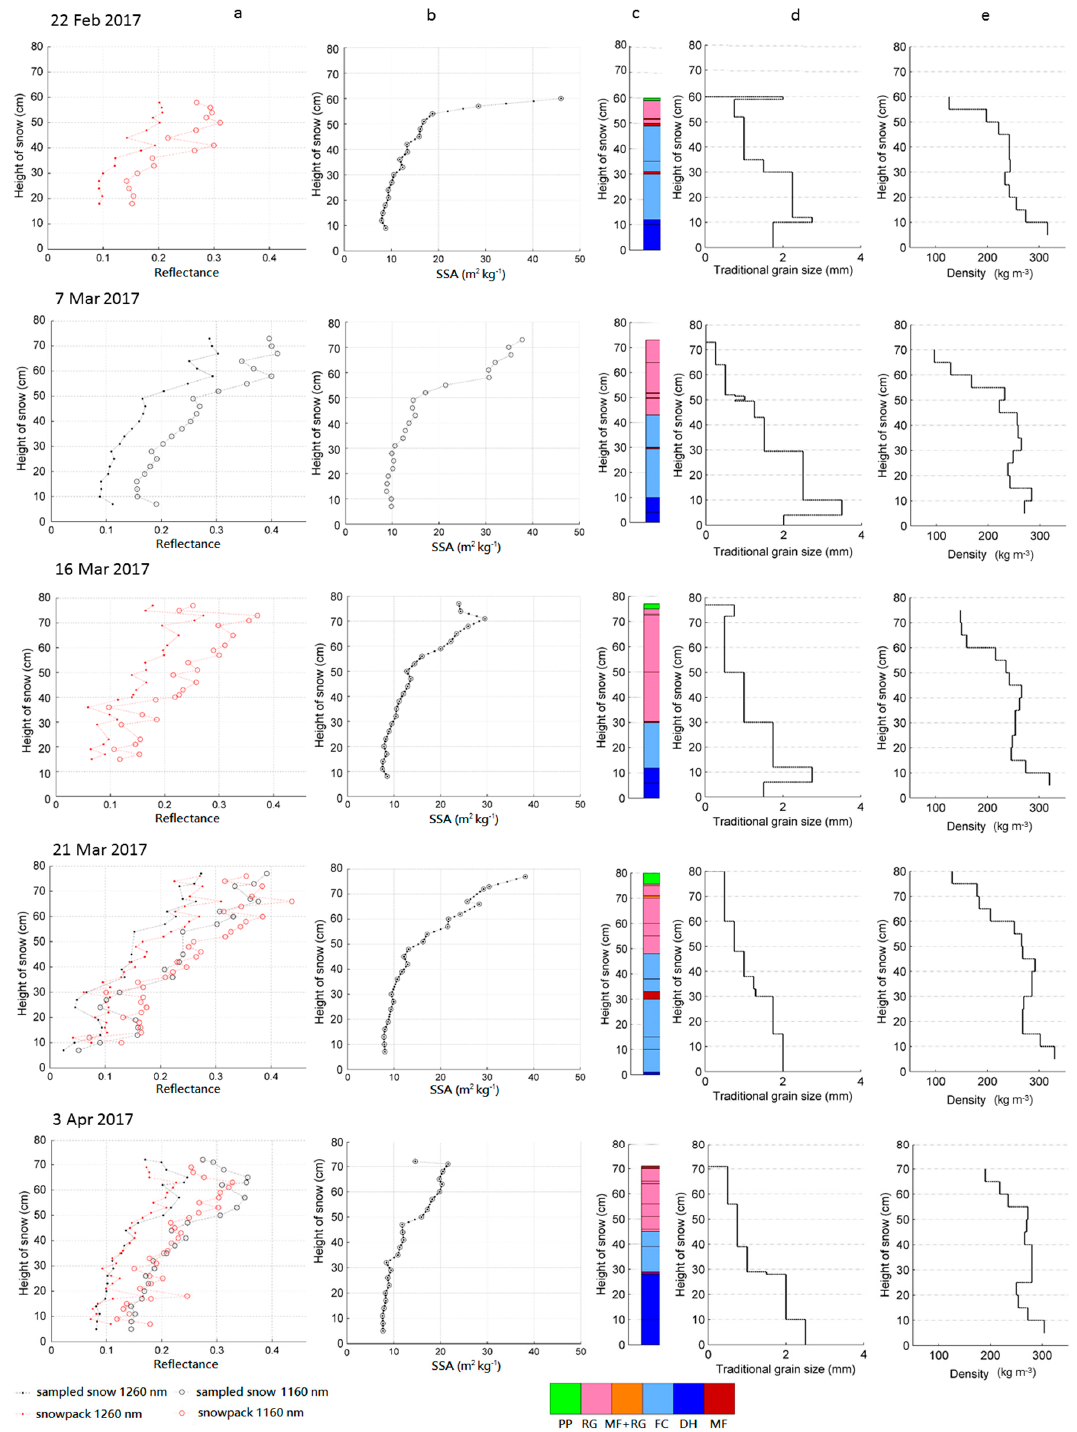
Figure 5. Reflectance from QST, specific surface area (SSA) from IceCube, grain type, macrophotography-based traditional grain size, and density profiles of snow are plotted in columns ( a – e ) for all dates. Original SSA data are marked with circles and interpolated values with dots in column ( b ). SSA for 21 March 2017 is plotted from the first measurement of three for every height. Grain type abbreviations are described in [4].